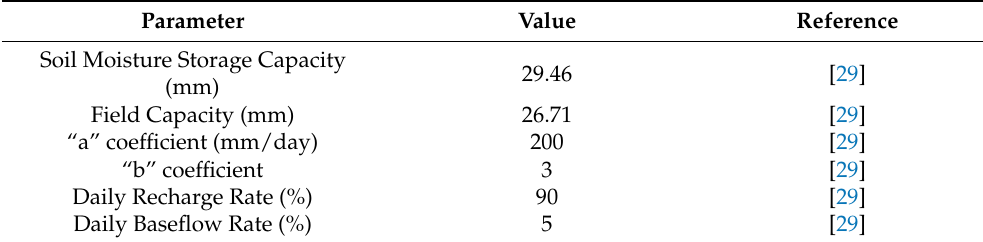
Table 3. Soil characteristics for the green roof in MUSIC’s land use